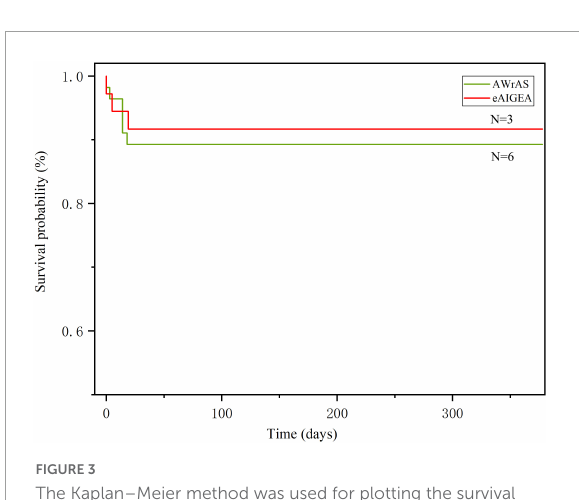
FIGURE3 The Kaplan–Meier method was used for plotting the survival curve. The log-rank ( P = 0.69) and Breslow ( P = 0.66) test results indicated that there were no differences in the short-term mortality rate between the two surgical